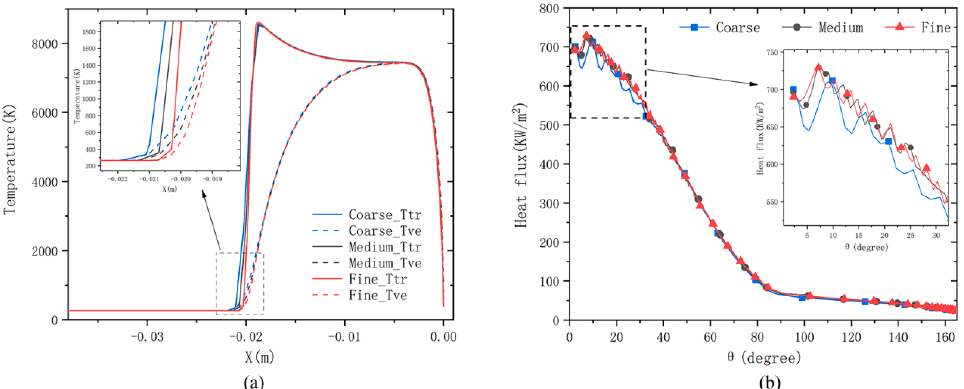
Figure 3. Grid convergence performed by no jet case. ( a ) Trans-rotational ( T tr ) and vibro-electronic ( T ve ) temperatures along the axis. ( b ) Heat flux along the surface.